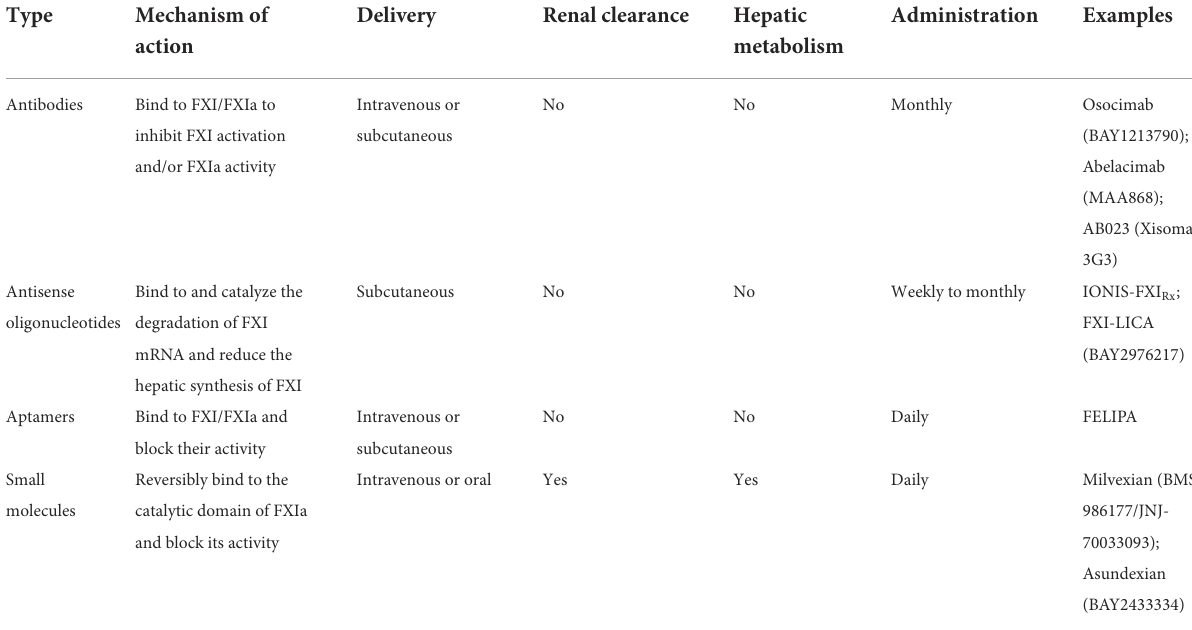
TABLE 1 Current strategies and features of factor XI/activated factor XI